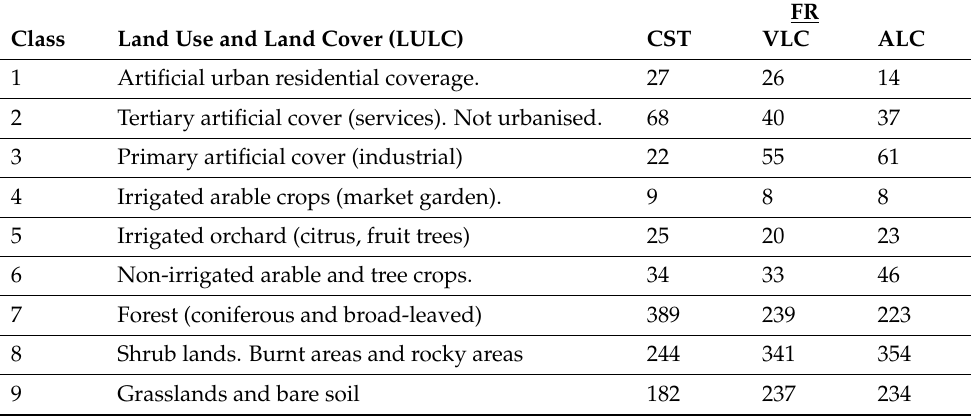
Table 4. Classes defined for LULC, according to SIOSE (2006). Provinces of Castellon (CST), Valencia (VLC) and Alicante